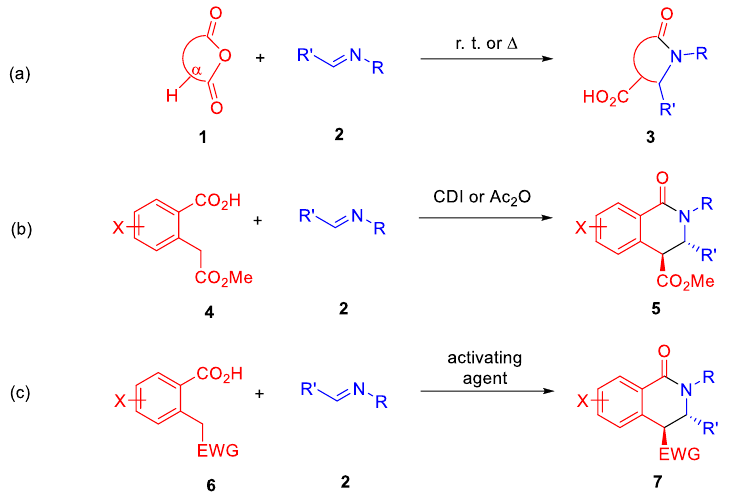
Figure 1. ( a ) The Castagnoli – Cushman reaction; ( b ) the recently developed CCR of homophthalic acid monoesters; ( c ) the reaction scope extended to electron-withdrawing groups other than methoxycarbonyl (this work).